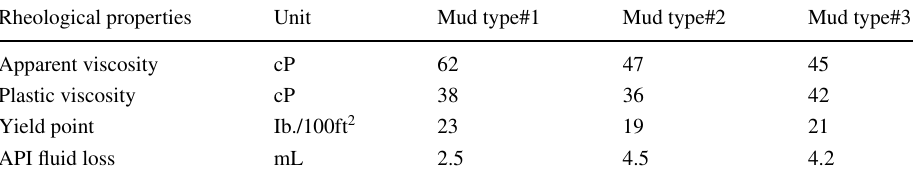
Table 3 Rheological properties of different mud types